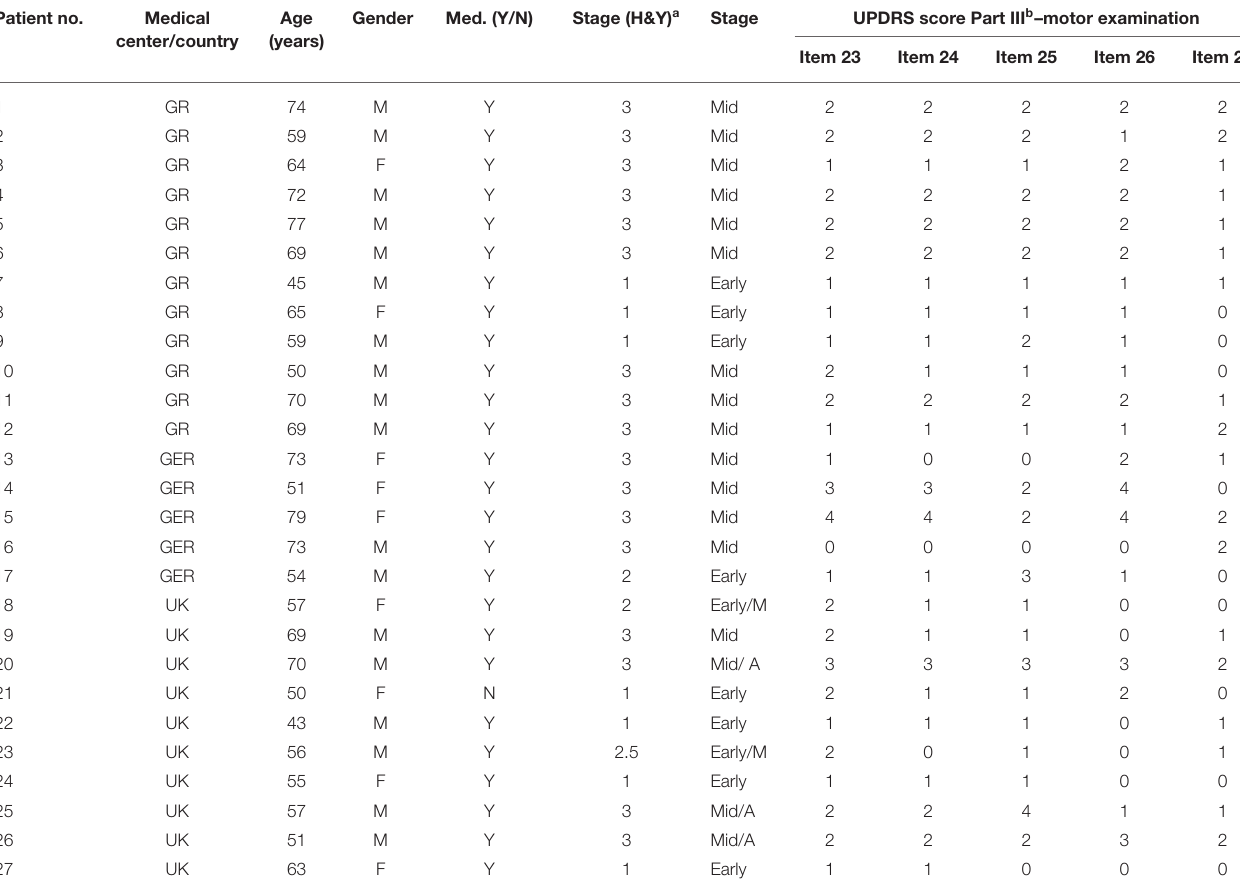
TABLE 2 | Demographics and UPDRS Part III clinical assessments of the recruited PD patients. Patient